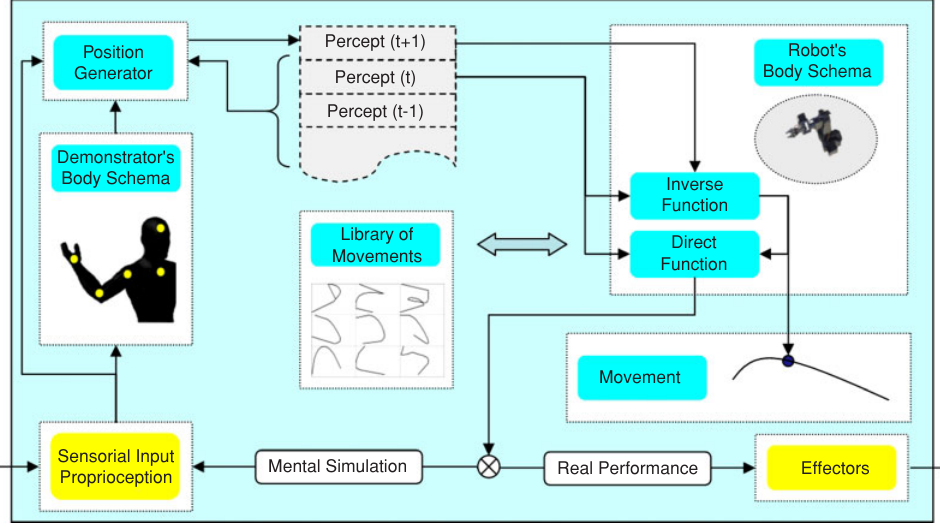
Figure 3 The mechanism of imitation for body